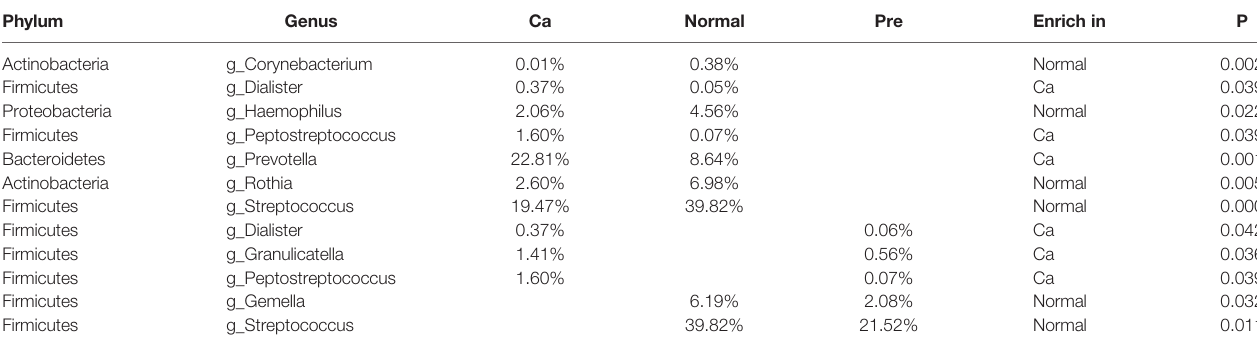
TABLE 3 | Abundances of dominant genera with signi fi cant differences among the three groups as estimated using STAMP.